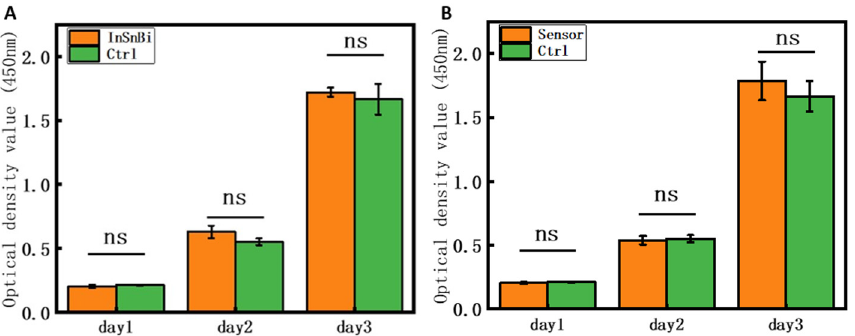
Figure 5. ( A ) The CCK-8 results of InSnBi extraction vs. negative control and ( B ) sensor extraction vs. negative control; ns: no significant difference.